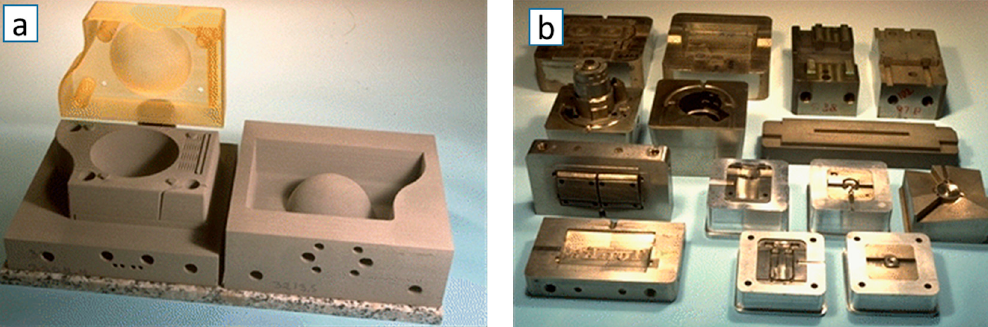
Table 1. Licensees by MIT for 3D printing technology.